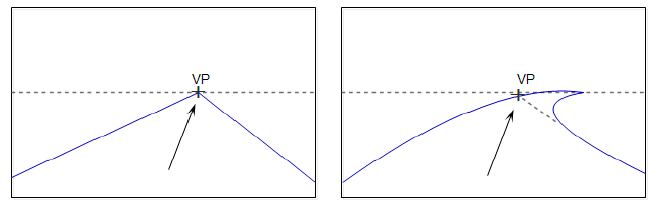
Figure 1. Vanishing point (VP) in the straight road ( left ) and curved road ( right ).